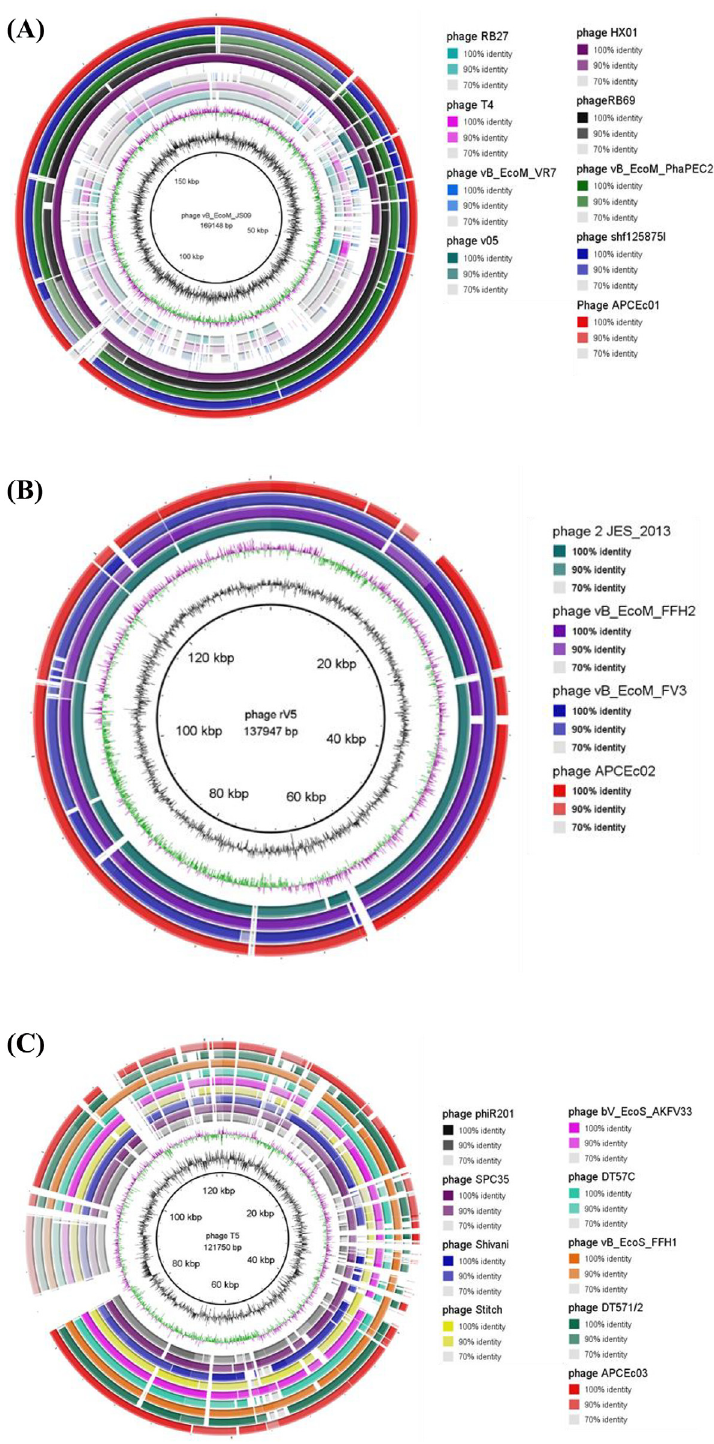
Fig 3. BLAST Ring Image Generator representation of phage ɸ APCEc01 (a), ɸ APCEc02 (b), and ɸ APCEc03 (c) genomes. The innermost rings show the GC content (black) and GC skew (purple: GC skew [-]; green: GC skew[+]). For each comparison using BRIG, the longest phage genome was used as a reference, and its name is indicated in the middle of the rings. The circles represent the genomes of the phages compared to this reference including the phages described in this